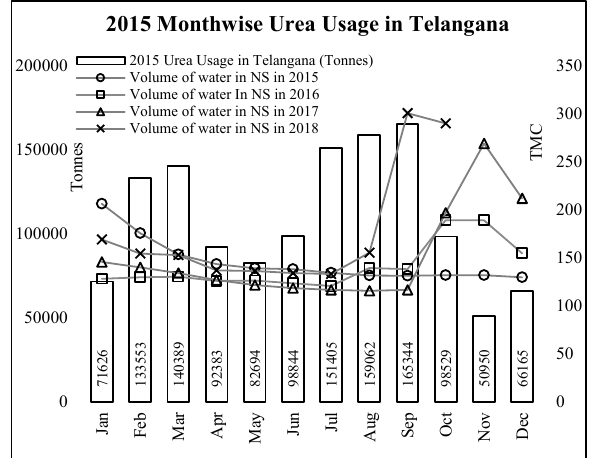
Figure 10: Shows the amount of monthly Urea usage in Telangana State, where NS is situated, for the year 2015 and also the volume of water in NS in TMC from 2015 – 2018.